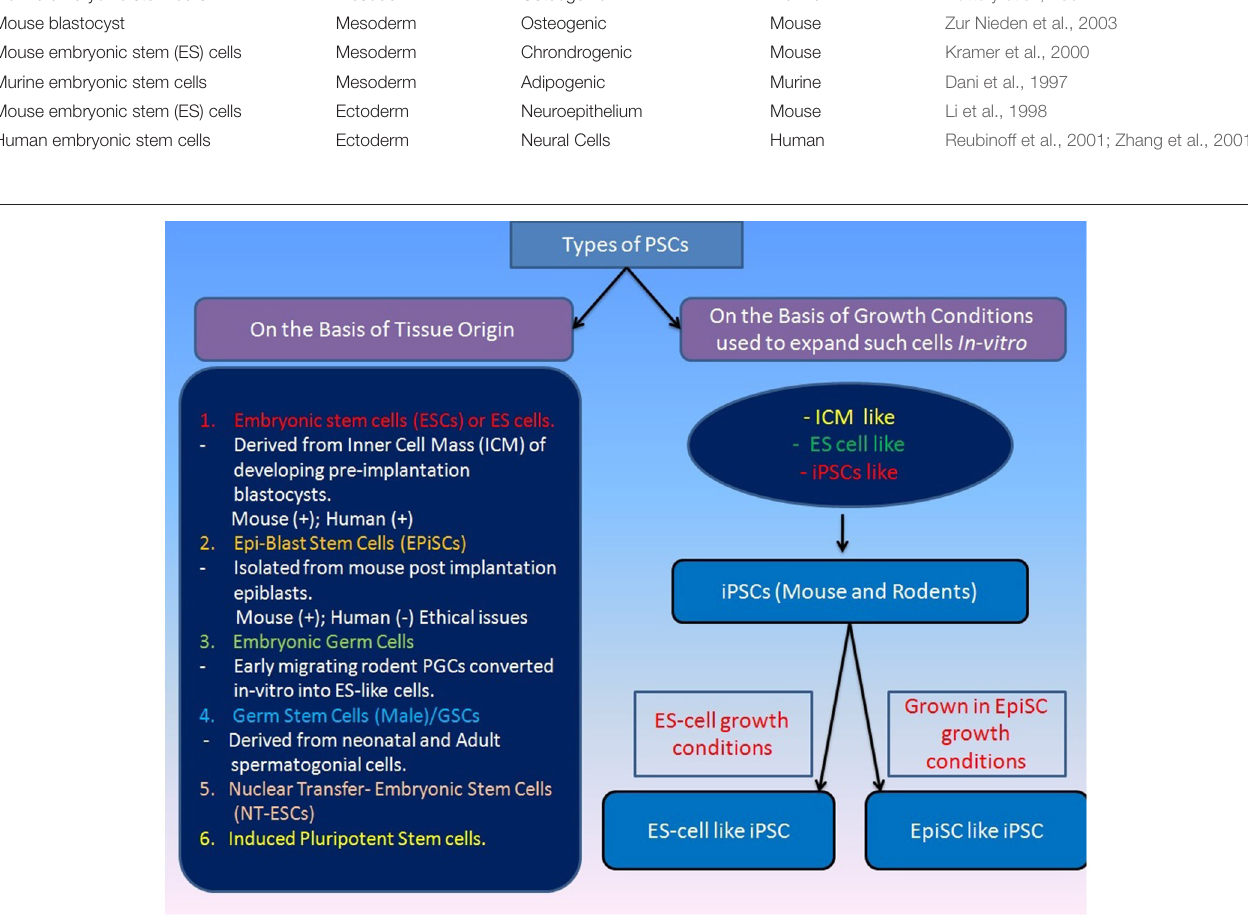
FIGURE 1 | Classification of various types of pluripotenct stem cells on the basis of their origin. Various types of pluripotent stem cells can be classified on the basis of their origin or source from where they are taken and this would directly define their self-renewing and differentiation potential. Pluripotency of stem cells is also regulated through their culture microenvironment and they are often named on the basis of their similarity to the various types of previously established PSCs e.g., ICM-like or ES-like PSCs. [Mouse ( + ), Human ( + ) indicates derivation of ESCs inthese mammals; Human( − ) indicates non-derivation of post-implantation EPIsc in